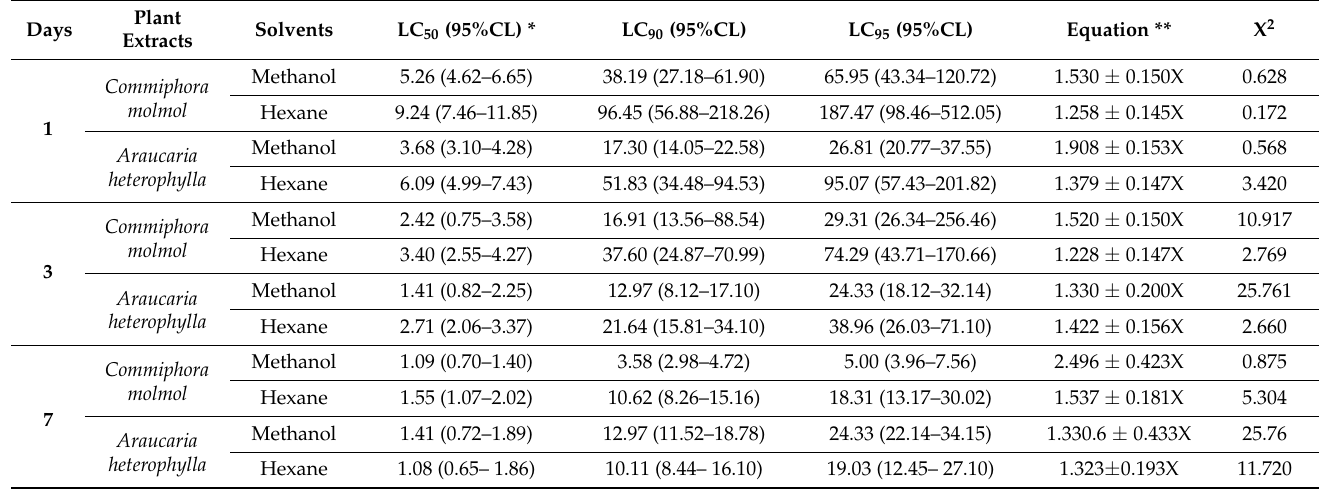
Table 4. Lethal concentration values of plant extracts of Commiphora molmol and Araucaria heterophylla against Rhipicephalus (Boophilus) annulatus